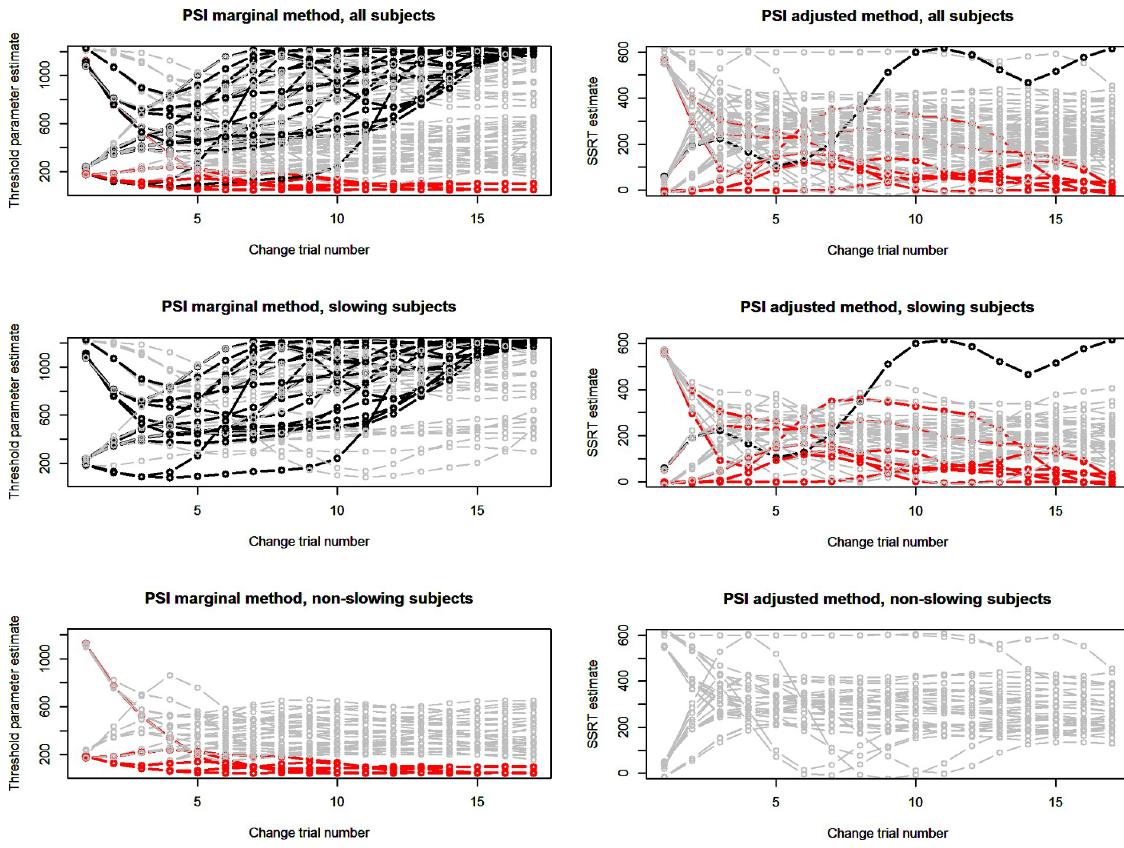
Fig 11. Parameter estimates for Experiment 1 and 2. Highest probability parameters for the PSI marginal method (Experiment 1) and PSI adjusted method (Experiment 2) over the course of the experiment. The participants were split intro groups depending on whether the showed go-response slowing. Every line represents one of the stop-change task’s conditions of one participant; thus, there are four lines per participant. Black lines indicate a parameter reaching the upper end of the parameter space, red lines indicate parameters reaching the lower end. Parameter estimates were slightly smoothed using a cubic spline to facilitate visual inspection. Note that while maximum probability parameters are shown, SSRTs are eventually computed based on the expected